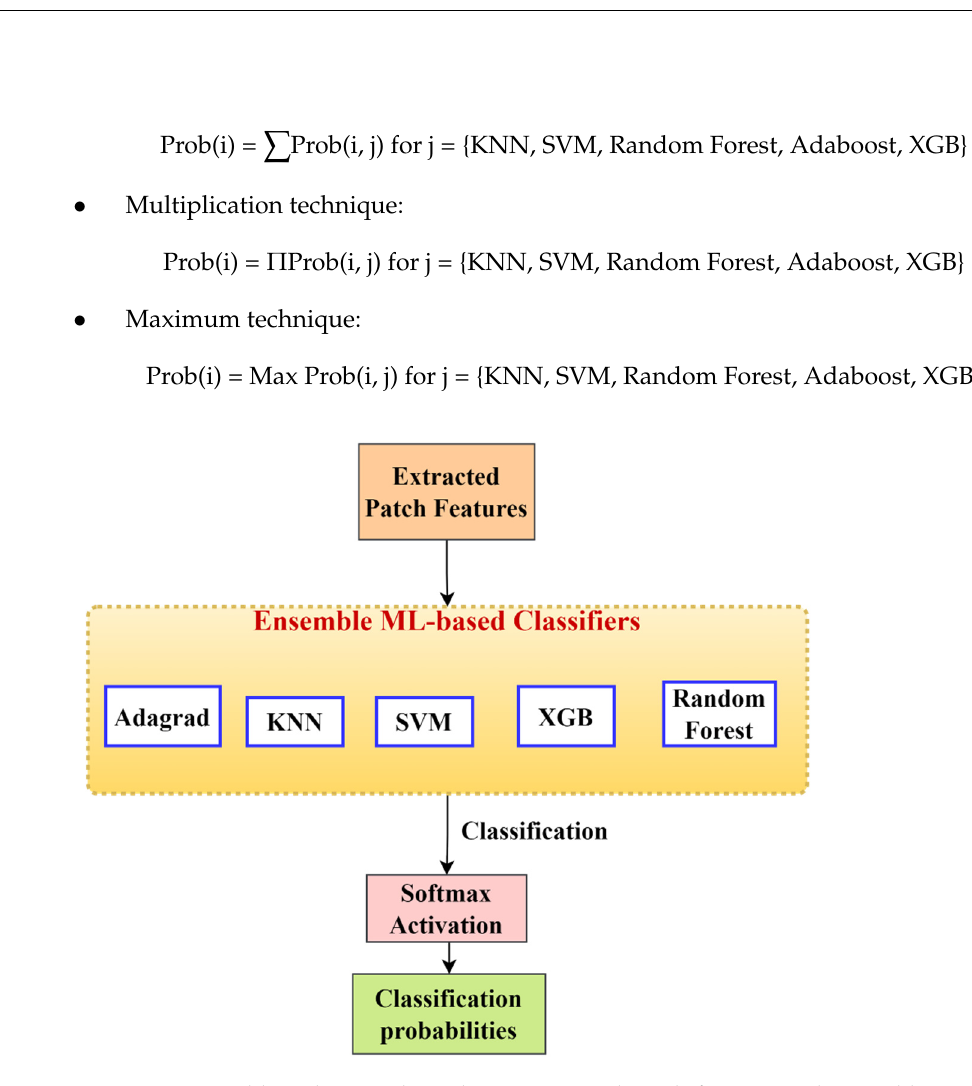
Figure 6. Ensemble technique that takes in extracted patch features and ensembles to give the classification probabilities for each patch.